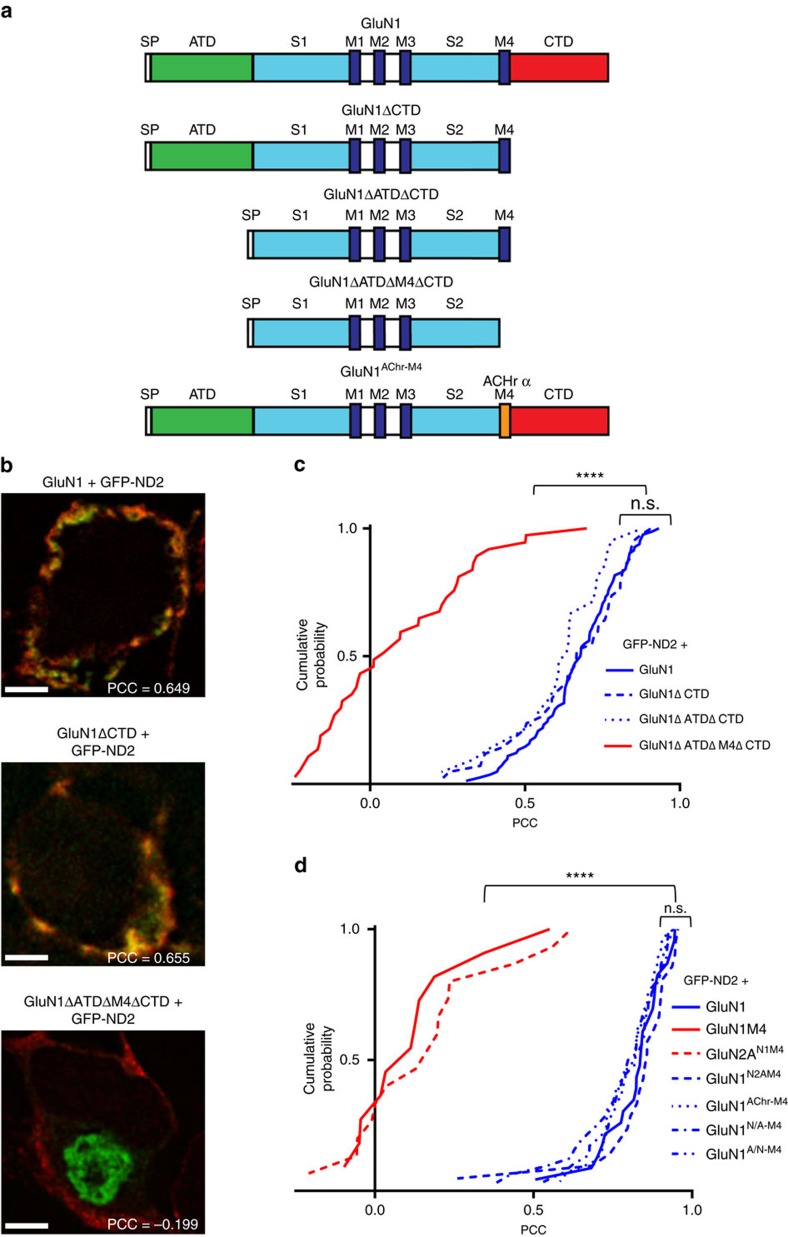
GluN1–M4 is necessary for ND2 co-localization.(a) Cartoon representation of GluN1 and subsequent deletion constructs. (b) Representative images of HEK293 cells expressing GFP-ND2+GluN1, GluN1ΔCTD, GluN1ΔATDΔCTD or GluN1ΔATDΔM4ΔCTD. (c) Cumulative frequency distribution of thresholded PCC values for GFP-ND2 with GluN1, (mean PCC=0.67±0.02; n=82), GluN1ΔCTD (0.65±0.03; n=42), GluN1ΔATDΔCTD (0.61±0.03; n=21), and GluN1ΔATDΔM4ΔCTD (0.09±0.04; n=37). (d) Cumulative frequency distribution of thresholded PCC values for GFP-ND2 with GluN1, (mean PCC=0.82±0.02; n=23), GluN1 M4 (0.12±0.06; n=11), GluN2AN1M4 (0.17±0.06; n=15), GluN1N2AM4 (0.83±0.03; n=21), GluN1AChr M4 (0.80±0.02; n=28), GluN1N/A M4 (0.78±0.03; n=32) and GluN1A/N M4 (0.80±0.02; n=29). Scale bar, 3 μm. Statistically significant differences between populations are indicated by the symbol ‘****'(P<0.0001), and were evaluated by Kruskal–Wallis non-parametric analysis of variance with Dunn's multiple post hoc comparison tests. n=# of cells. Results are presented as mean±s.e.m. See also Supplementary Figs 4–6 and Supplementary Table 1.